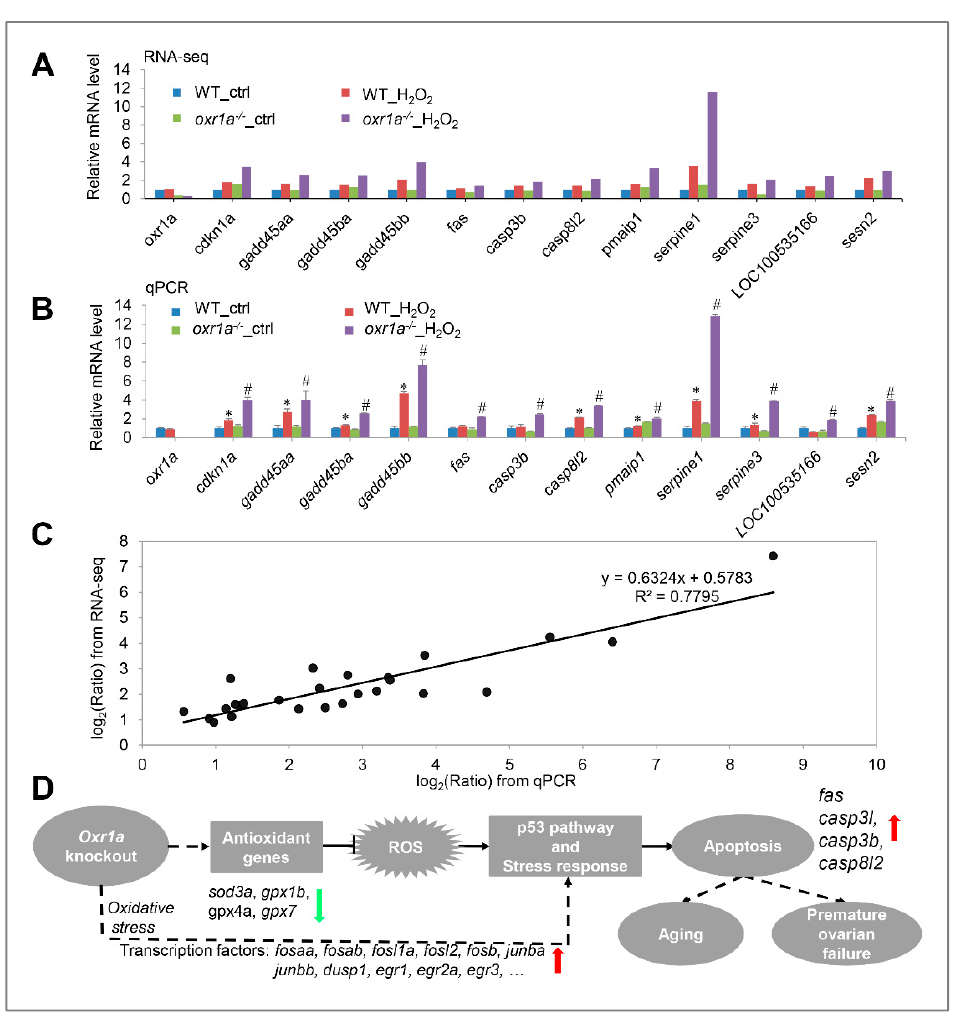
Figure 12. ( A ) RNA-seq data displayed the expression of 12 DEGs in the p53 signaling pathway. ( B ) The same genes were examined by qPCR. ( C ) Scatter plot of gene expression in qPCR (x-axis) and RNA-seq (y-axis). The “Ratio” of log 2 (Ratio) indicates the fold change in gene expression. The linear relationship is presented by a reference line, and related index R 2 = 0.7795. ( D ) Schematic diagram of oxr1a regulating the antioxidant defenses, early stress response and apoptosis. In zebrafish, oxr1a scavenges ROS by increasing the expression of several antioxidant genes, thereby modulating early stress response and suppressing apoptosis. Due to the downregulation of multiple antioxidant genes, zebrafish oxr1a mutation may enhance DNA damage during oxidative stress, thereby triggering apoptosis via the regulation of fas , casp3b , casp3l , casp8l2 and several other genes of the p53 signaling pathway. In addition, oxr1a may indirectly or directly regulate the early stress response and apoptosis through interaction with transcription factors (e.g., fosaa, fosab , junba, junbb, dsup1 and egr1 ). Red and green arrows indicate up- and downregulation of gene, respectively, in oxr1a − / − mutant zebrafish during oxidative stress. The solid line indicates a direct interaction, while the dotted line indicates a direct or indirect interaction. * p < 0.05 compared to WT_ctrl; # p < 0.05 compared to oxr1a − / − _ctrl